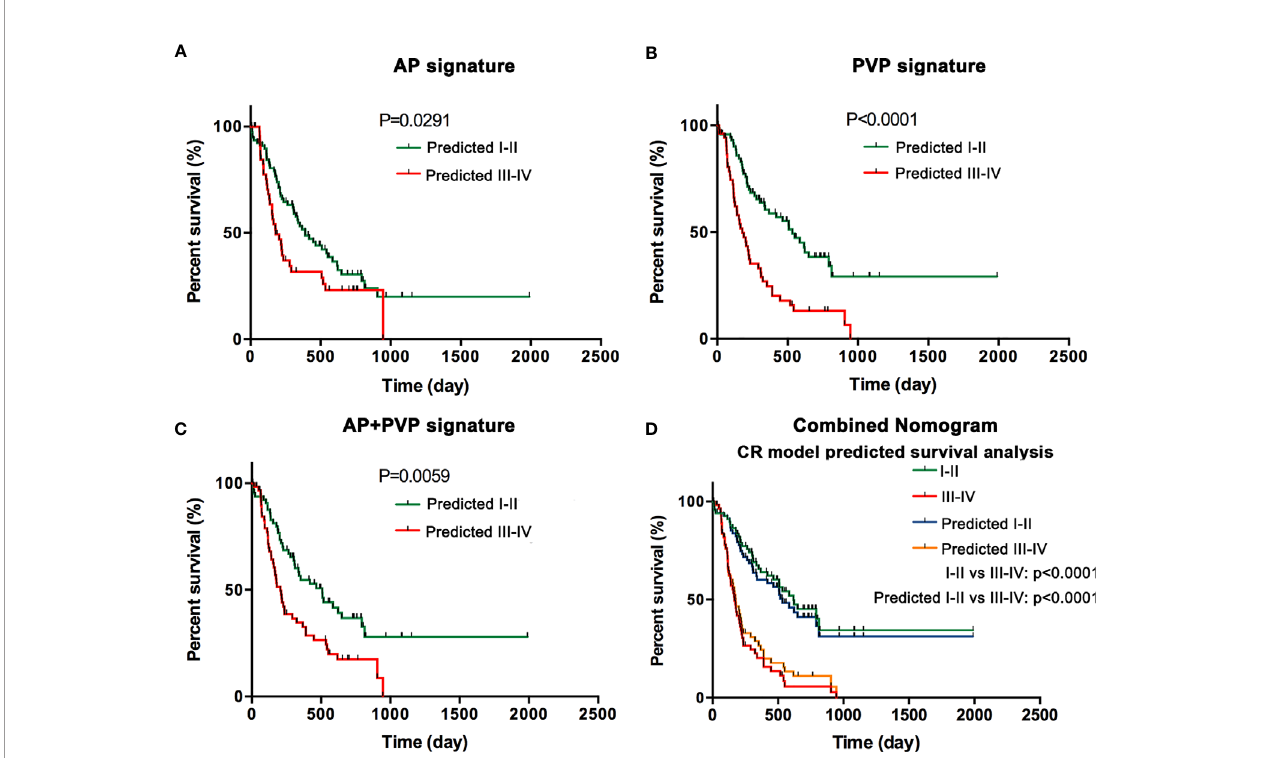
FIGURE 6 | Survival analysis. (A) Kaplan-Meier curves in the AP model. (B) Kaplan-Meier curves in the PVP model. (C) Kaplan-Meier curves in the AP+PVP model. (D) Kaplan-Meier curves using histopathological cancer stage and nomogram model-predicted cancer stage. Survival analyses show signi fi cant differences between the predicted stage I-II and III-IV groups. AP, arterial phase; PVP, portal vein phase.